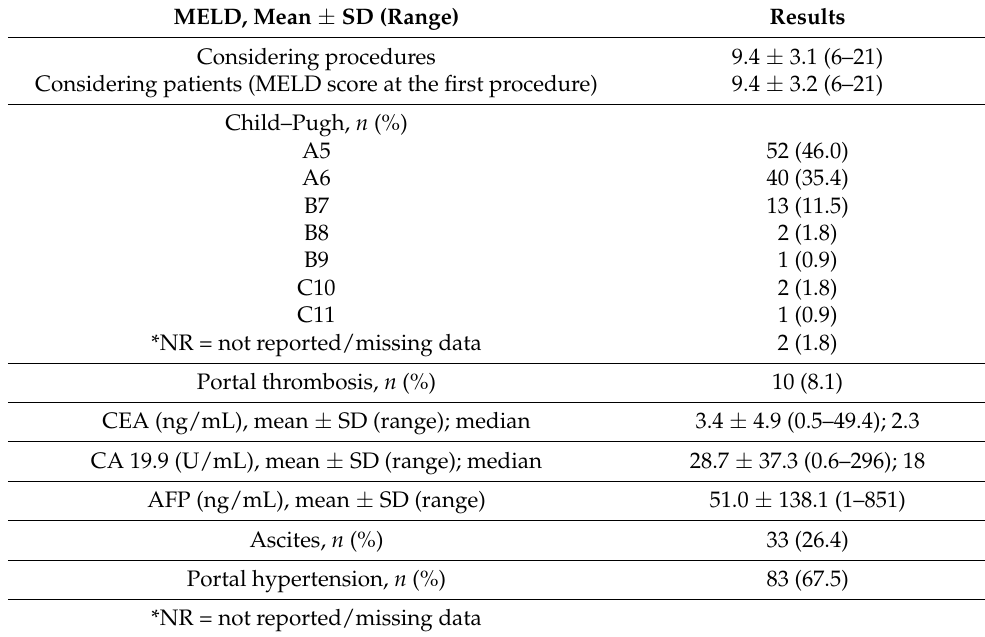
Table 2. Disease parameters in our sample.